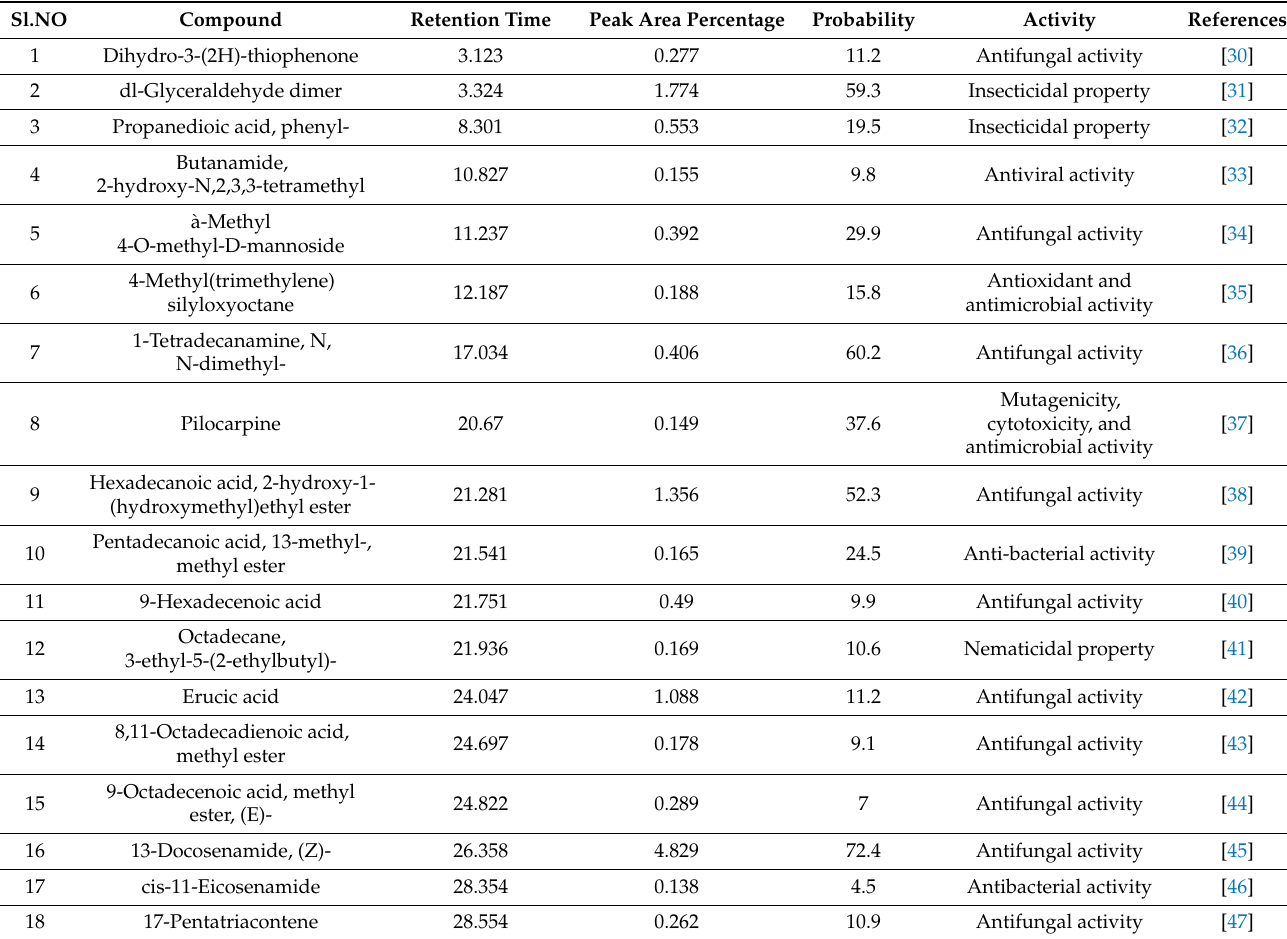
Table 2. Metabolite fingerprinting of the volatile/non-volatile bioactive compounds extracted from the ethyl acetate fractions of C. rosea TNAU-CR